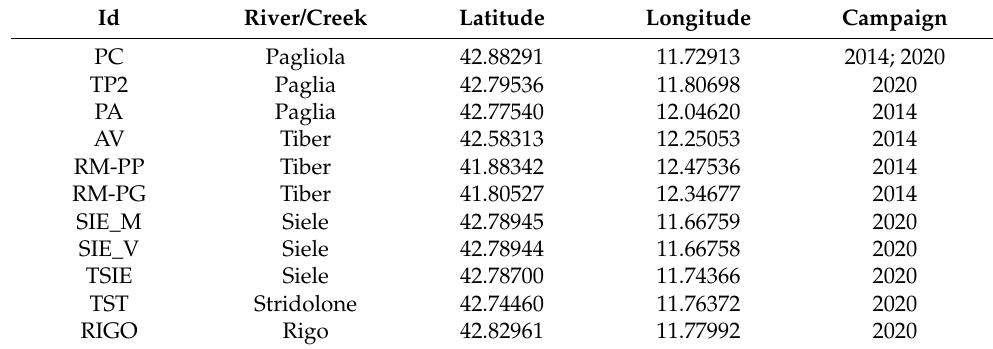
Table 1. Location of the sampling